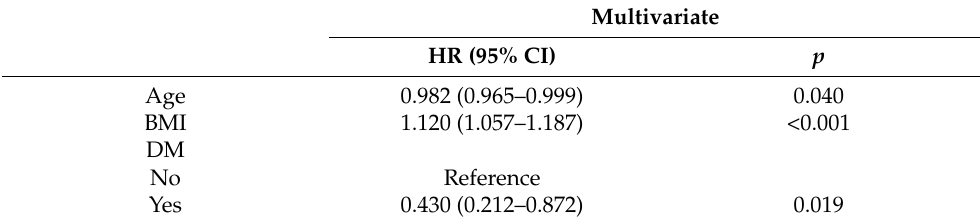
Table 3. Multivariate logistic regression analysis of factors associated with compensation from postoperative 1 week to postoperative 5 years (process 2) in patients treated with radical nephrectomy for RCC.